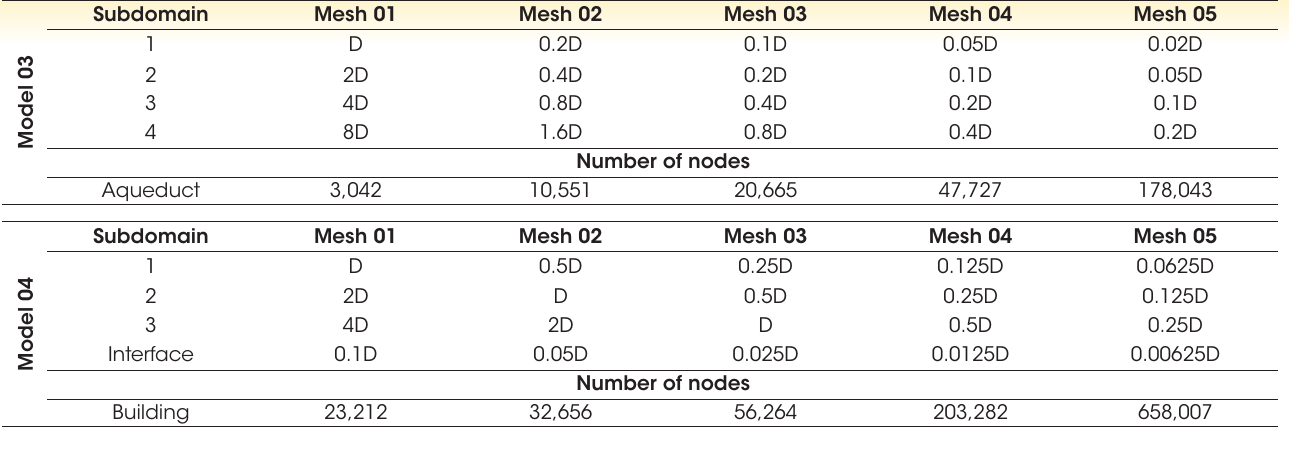
Mesh refinement – element size in meters